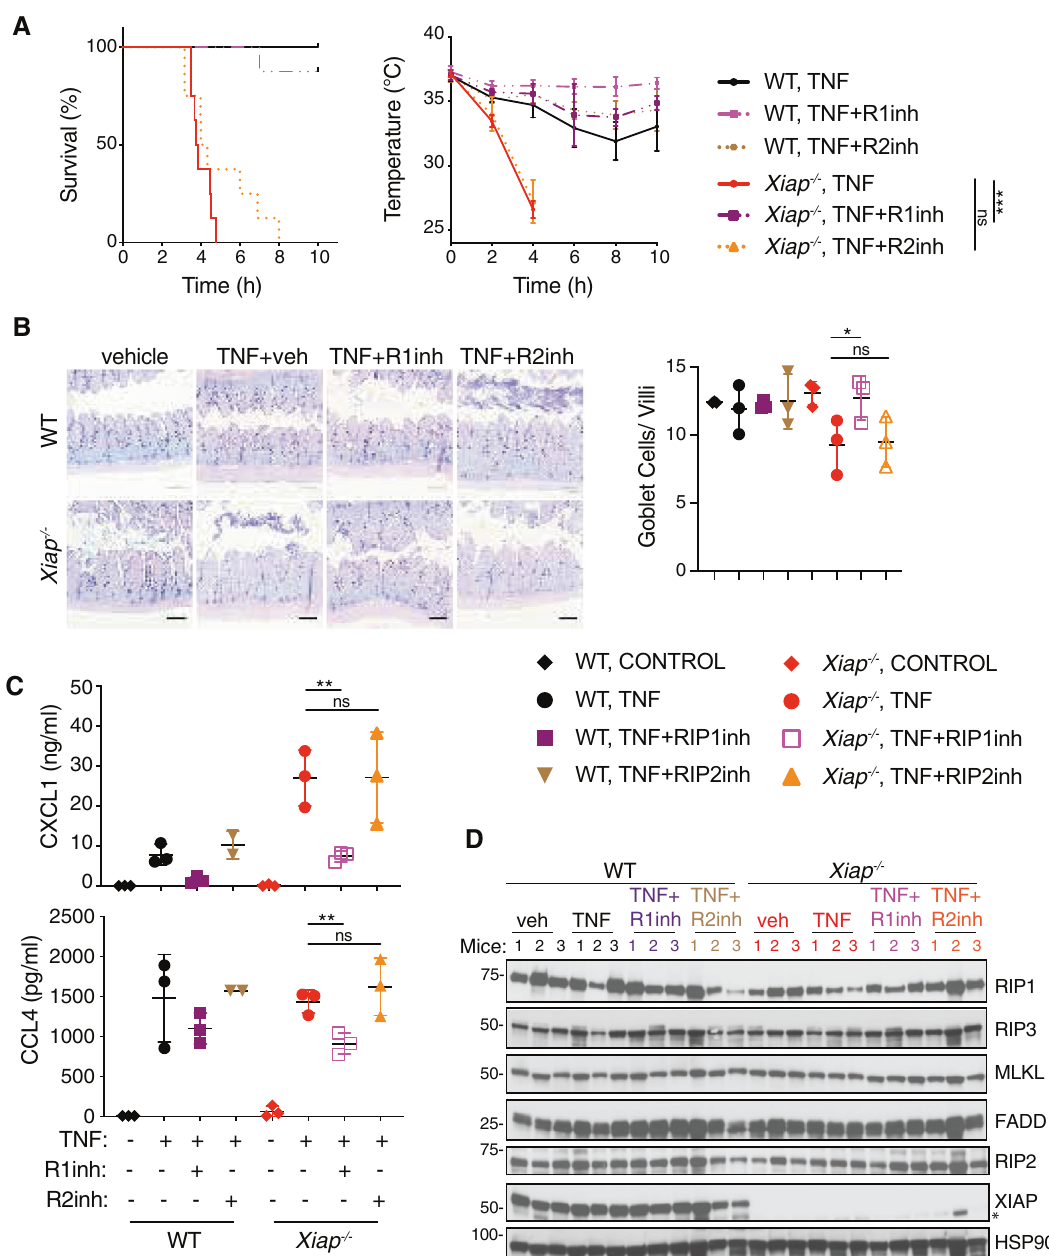
Fig. 3 XIAP deletion sensitizes mice to RIP1-dependent TNF-induced lethality and intestinal damage. WT and Xiap − / − mice were given vehicle or TNF (500 μ g/kg) in the absence or presence of RIP1 inhibitor GNE684 (50 mg/kg) or RIP2 inhibitor GSK583 (30 mg/kg). A TNF induced lethality (left) and hypothermia (right) in WT and Xiap − / − mice treated with RIP1 inhibitor GNE684 or RIP2 inhibitor GSK583. ( n = 7 mice for Xiap − / − TNF + R1inh treatment, n = 8 mice for all other treatments). B RIP1 inhibition restores Goblet cells in TNF treated (2 h) Xiap − / − mice. Representative images shown on the right and quanti fi cation on the left. Size bars = 100 μ m. ( n = 3 mice for each treatment). C RIP1 inhibitor GNE684 reduces the release of CXCL1 and CCL4 in TNF treated (2 h) Xiap − / − mice. ( n = 2 mice WT treated with TNF + R2inh, n = 3 for all other treatments). D Protein levels in small intestines of WT and Xiap − / − mice treated with TNF (2 h) in the absence or presence of RIP1 or RIP2 inhibitors. Western blots were performed with indicated antibodies ( n = 3 mice for each treatment). Asterisk indicates nonspeci fi c band. In A, bars indicate median with standard error, and in B , C mean with standard deviation. Ns indicates no signi fi cance, * p < 0.05, ** p < 0.01, *** p <